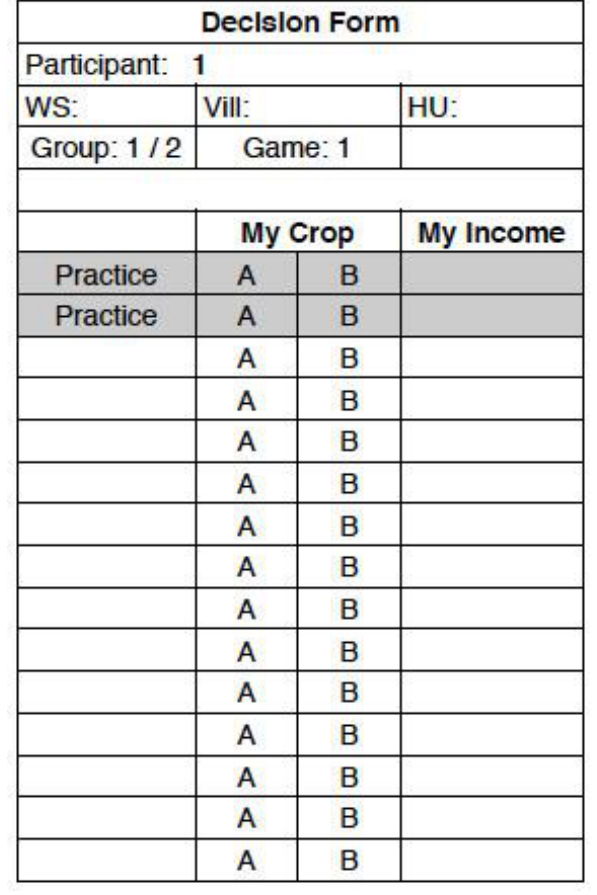
Figure 3. Participant Decision Form (also shown in large-format to participants for